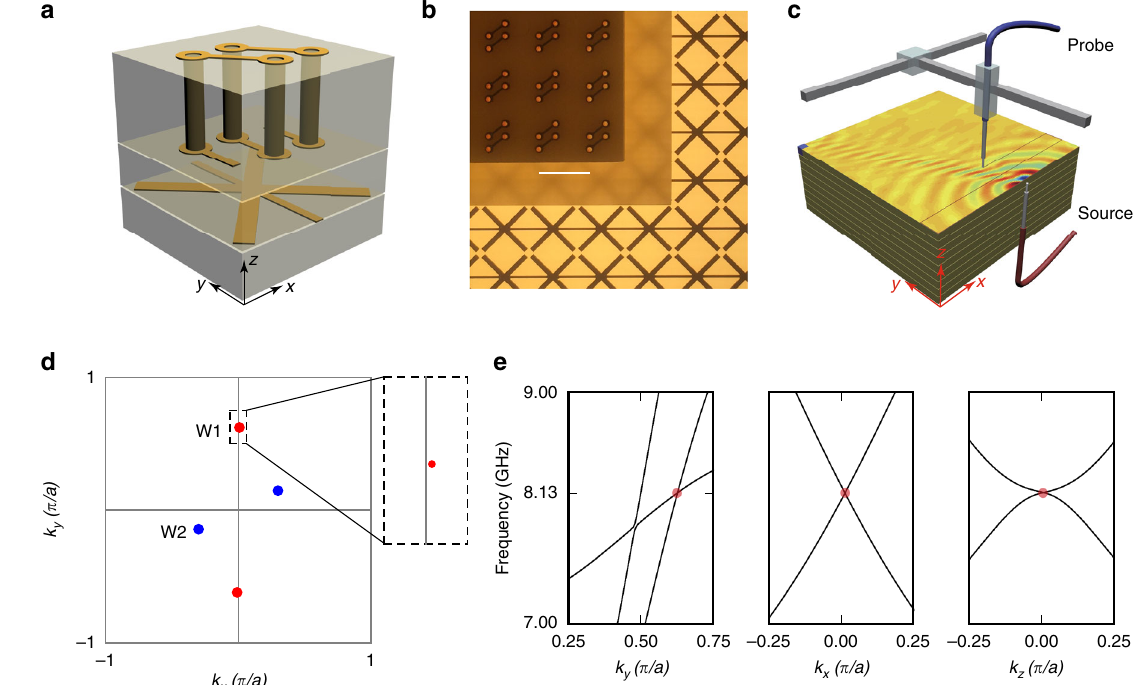
Fig. 2 Photonic type-II Weyl nodes realized within a chiral hyperbolic metamaterial. a Schematic of the cubic unit cell of chiral hyperbolic metamaterial (CHM) with side length a = 4 mm, consisting of three layers; bottom hyperbolic layer (thickness = 1 mm), middle blank layer (thickness = 1 mm), and top chiral layer (thickness = 2 mm). Each helix has 2.5 turns, with its axis along the x -direction. Its length and cross-sectional area are optimized to give a fundamental resonance frequency around 5 GHz. The blank layer (FR4) between the chiral and hyperbolic layer is designed to avoid shorting contact between them. b Tri-layer sample fabricated with printed circuit board technology. There are 75 unit cells (4 × 4 mm 2 ) along the in-plane directions on each layer. On the hyperbolic layer, metallic lines go through the whole layer along the y -direction. The scale bar indicates 4 mm. c Experimental setup and layer-stacking geometry. The fi eld pattern represents the real experimental data scanned under x (polarized source) − z (polarized probe) con fi guration at 5.82 GHz. The surface wave is excited by one antenna, whilst another serves as a probe scanning the propagating near fi eld. d The slice of the fi rst Brillouin zone with respect of k z = 0 and locations of Weyl points for W1: ( ± 0.01, ± 0.62) π / a and W2: ( ± 0.30, ± 0.14) π / a . The zoomed-in rectangle indicates that W1 is located slightly away from the k y axis. e Simulated linear degeneracy around type-II Weyl point W1 (8.13 GHz) with the realistic structure designed